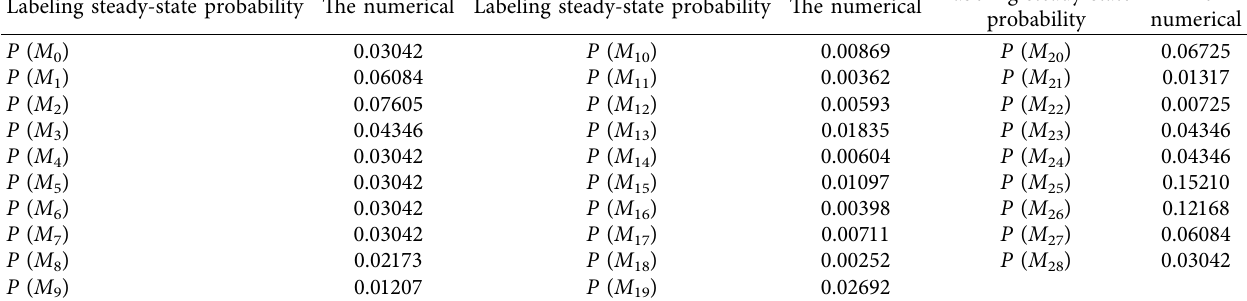
Table 4: The steady-state probability of each